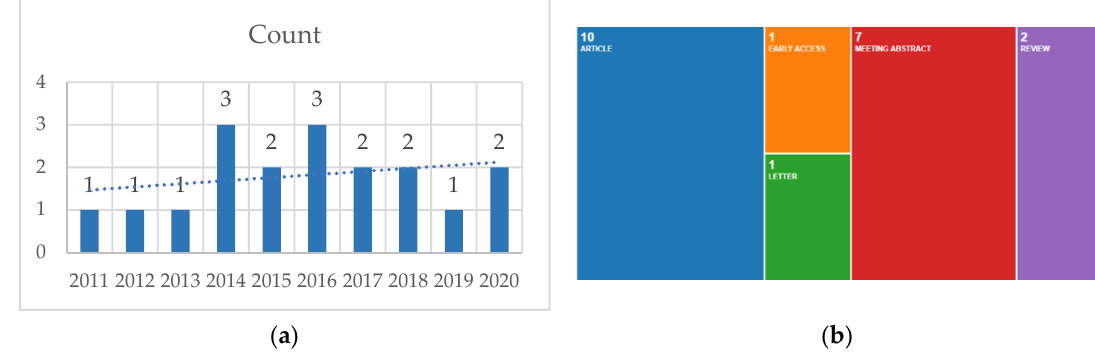
Figure 9. The data search on clozapine and Romania search query ( a ) on PubMed ® —all-time papers published by year ( n = 18) ( b ) Web of Science ® —fourteen papers during the last ten years, four reviews and ten articles (one early access).